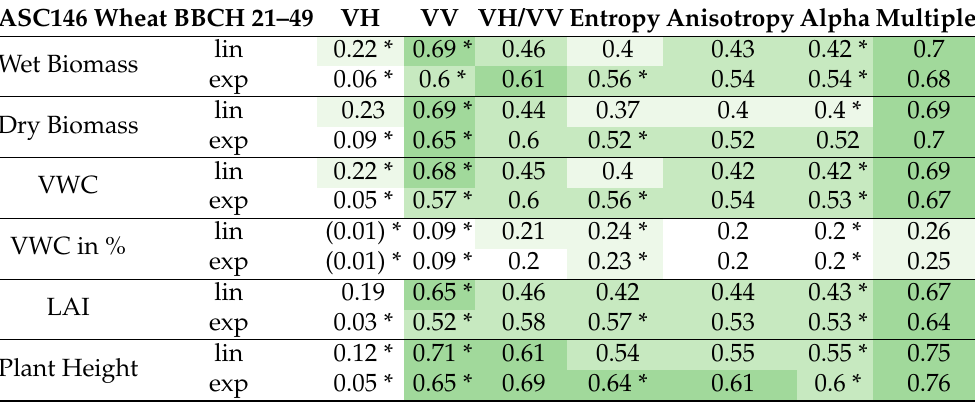
Table 5. R 2 values of the regression between crop parameters and backscatter and dual-polarimetric parameters for all wheat fields in BBCH stages 21–49: values in parentheses are not significant ( p > 0.01). The parameters of values with asterisk contribute to the multiple regression model. The darker the shade of green, the higher the R 2 value.